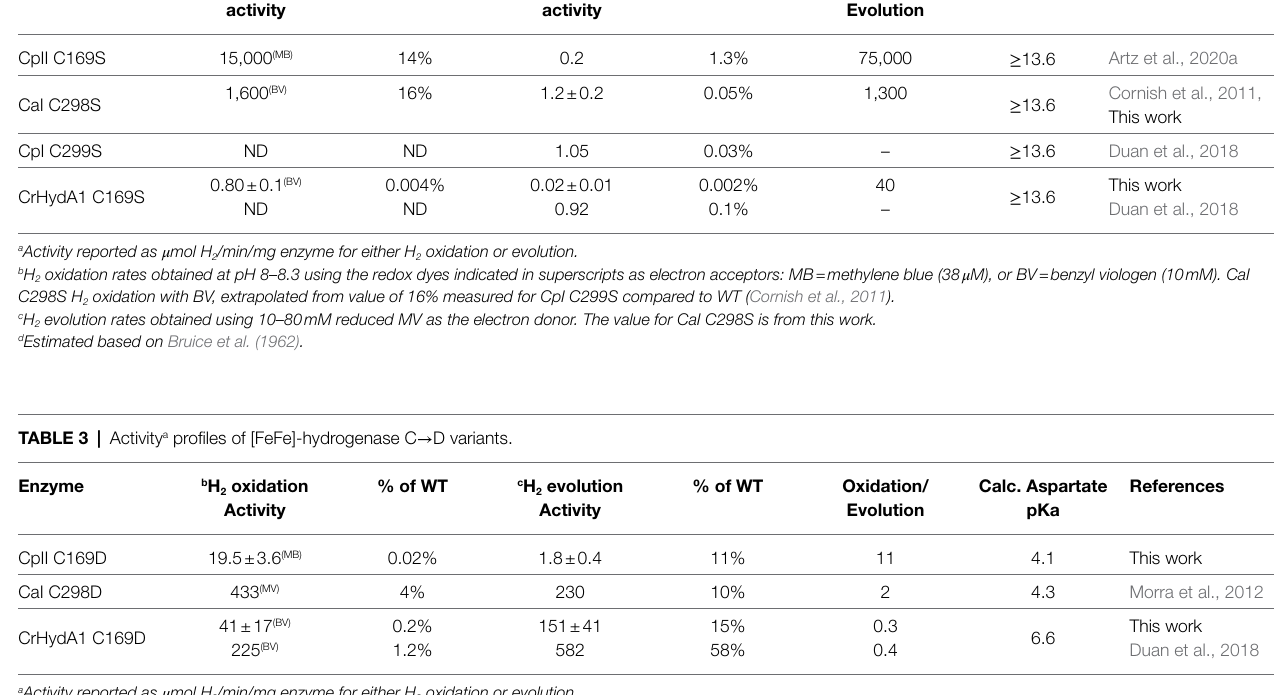
TABLE 2 | Activity a profiles of [FeFe]-hydrogenase C → S variants.